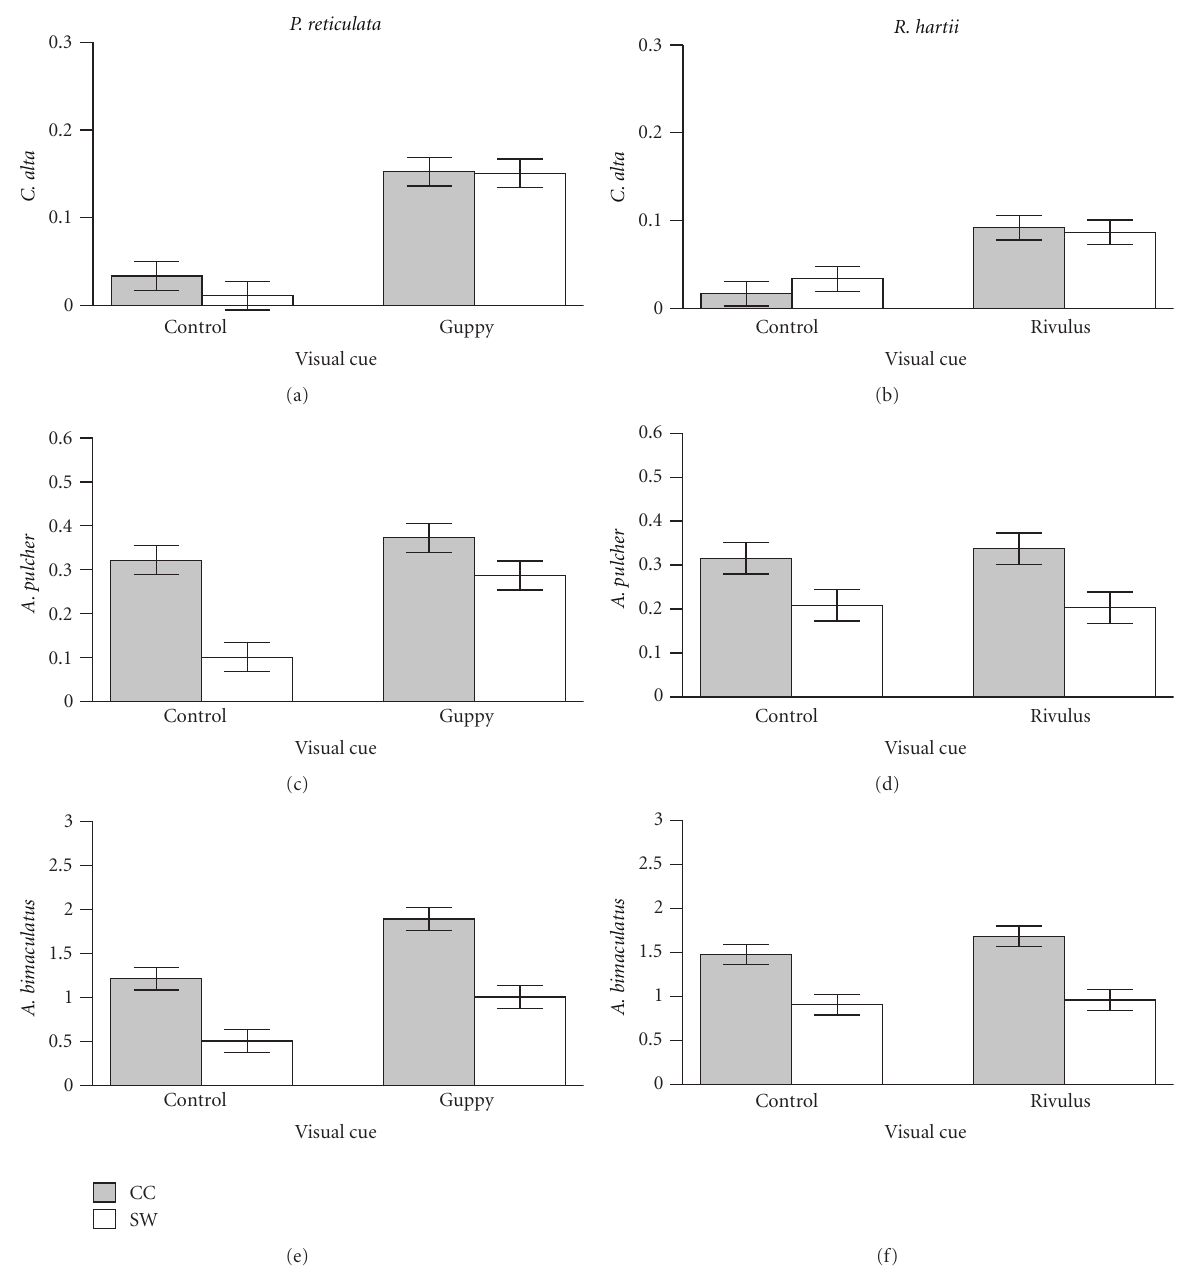
Figure 1: Mean ( ± SE) number of predators present within a 1.5 m radius of prey cue presentation sites in the Lower Aripo over 5 minutes. Crenicichla alta attraction to (a) guppy Poecilia reticulata and (b) rivulus Rivulus hartii cues. Aequidens pulcher attraction to (c) guppy and (d) rivulus cues. Astyanax bimaculatus attraction to (e) guppy and (f) rivulus cues. Visual cues (horizontal axes) were paired with either conspecific chemical cues (shaded bars) or a stream water control (open bars). N = 16 for each cue combination. pulcher responses (65.4%) were intermediate relative to the other two